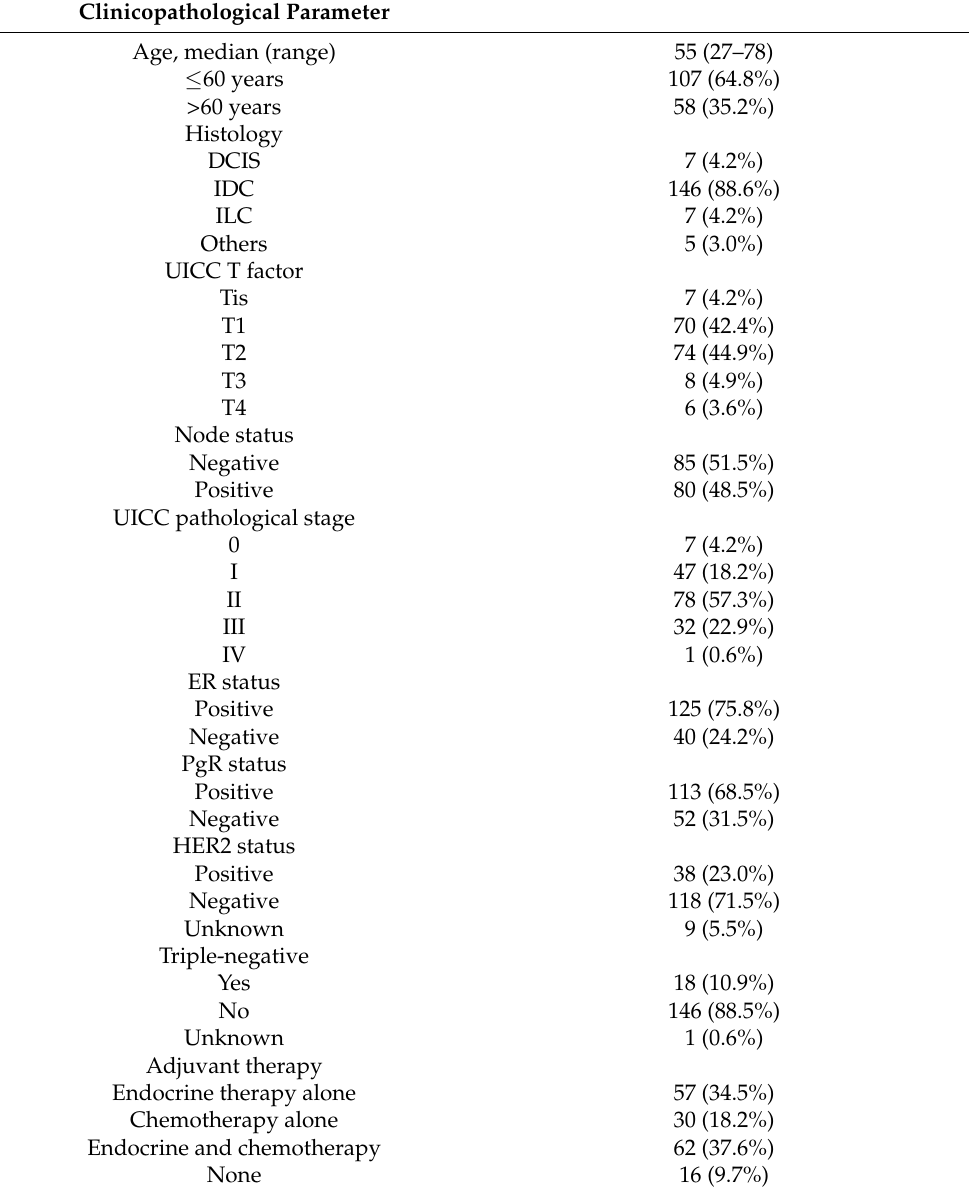
Table 2. Clinicopathological characteristics of 165 patients with breast